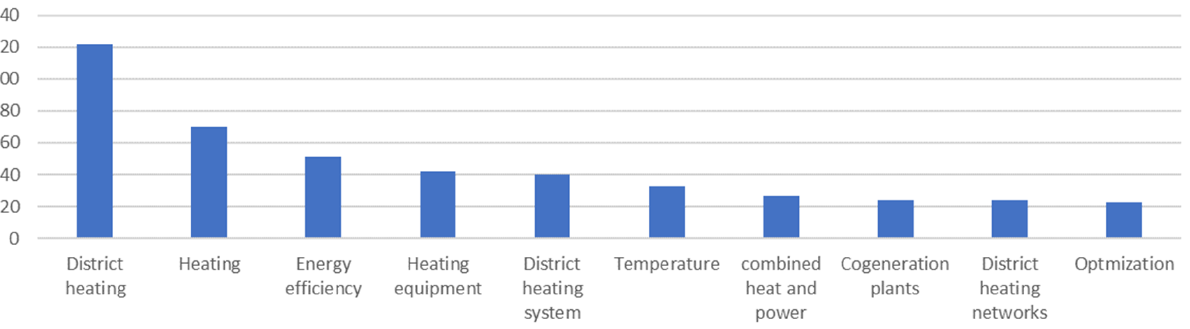
Figure 13. DH systems—most frequent keywords (horizontal axis) and the number of articles (vertical axis).